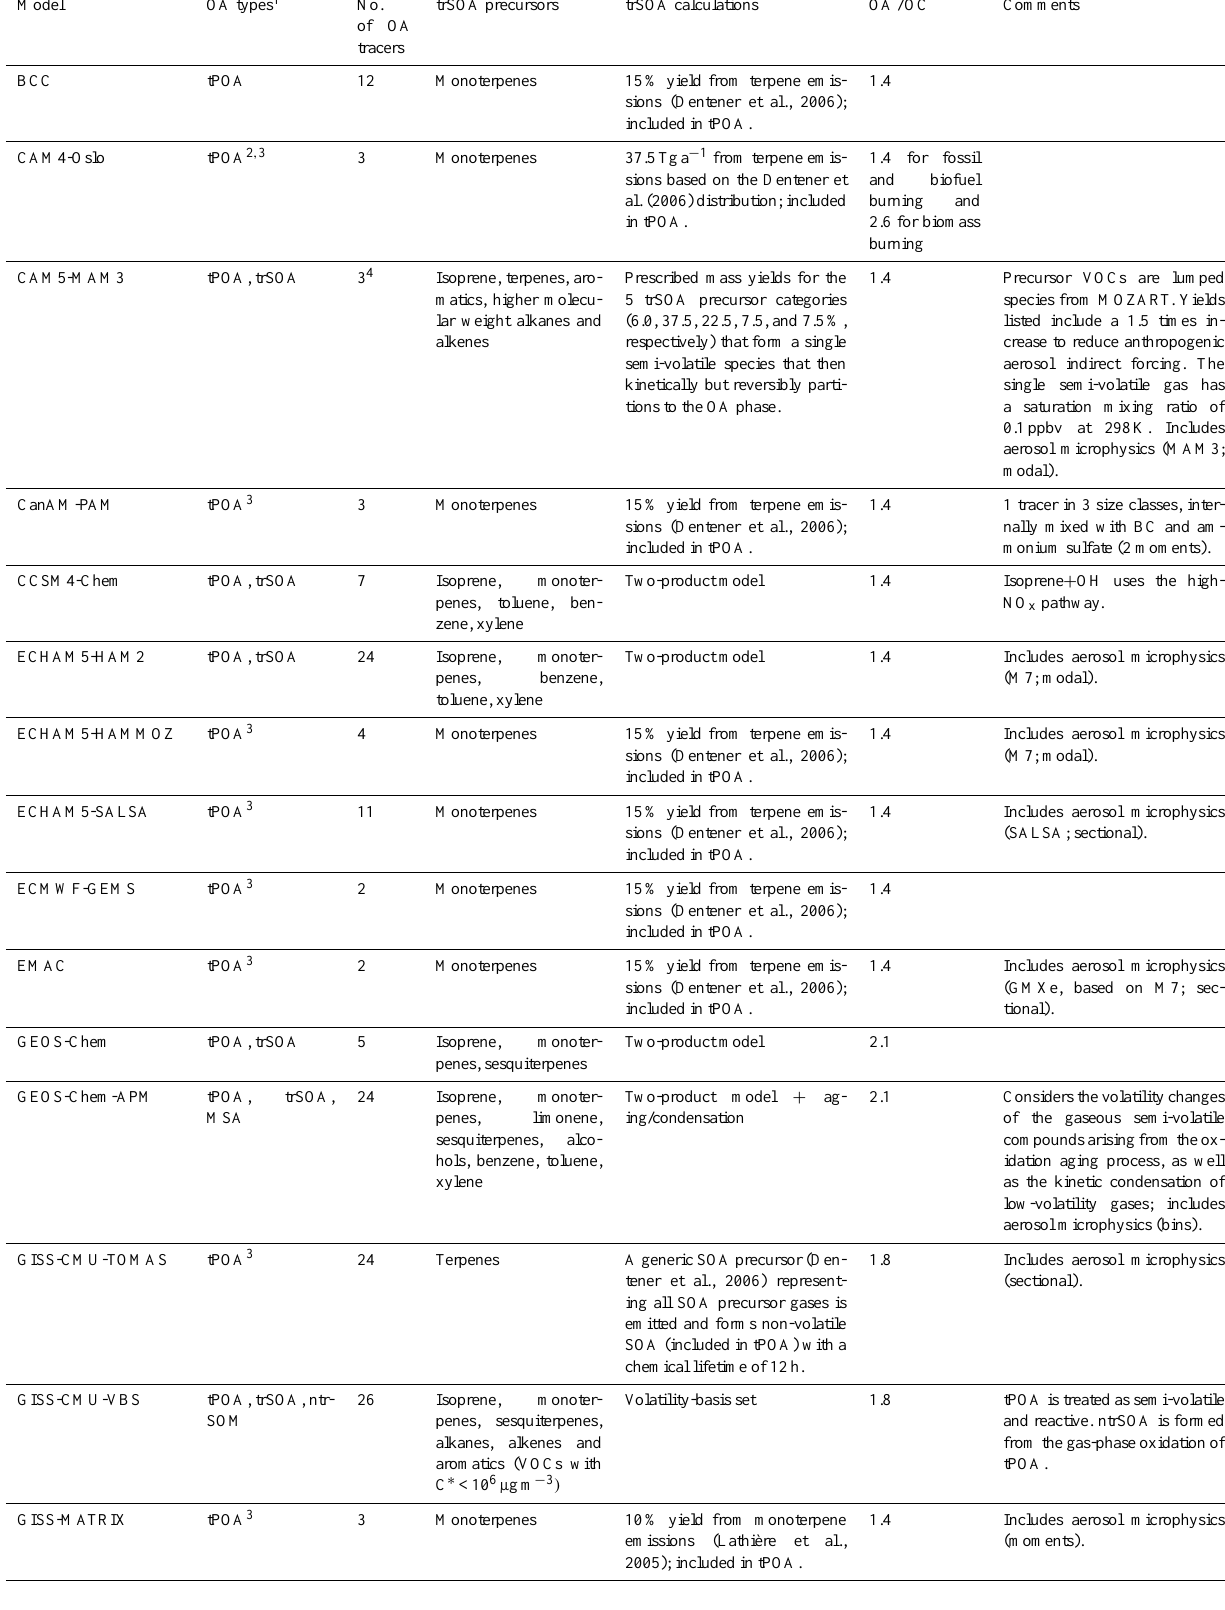
Table 1. Organic aerosol representation in the